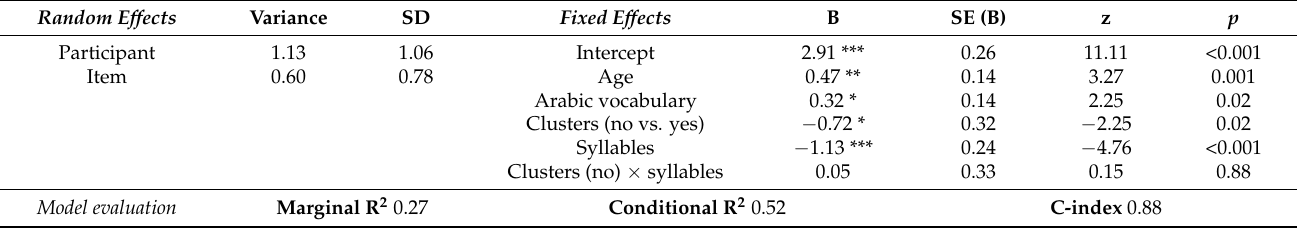
Table 8. Summary of Model 5: accuracy, NWRT-Leb